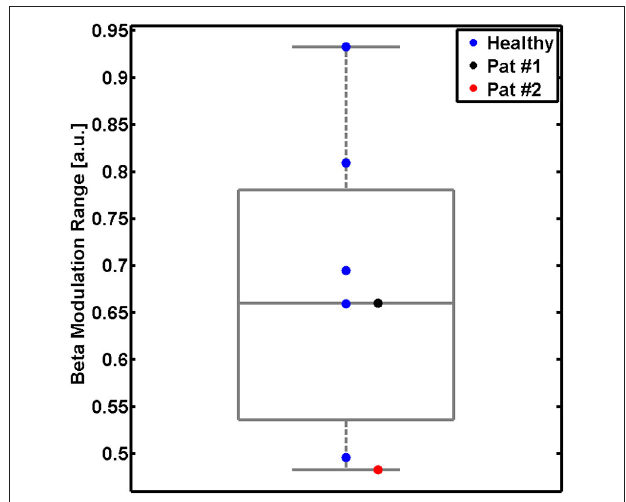
FIGURE 4 | β -modulation range during the proprioceptive feedback condition. Modulation range for five healthy subjects (single blue dots and group results as boxplot) and for two stroke patients (black and red dots). This measure reflects the individual ability to modulate sensorimotor β -oscillations captured with the feedback electrodes. The β -modulation range is defined in the individual frequency bin of the event-related spectral perturbation (ERSP) with the largest difference between the motor imagery (MI) epoch (the minimum) and in the rest epoch (the